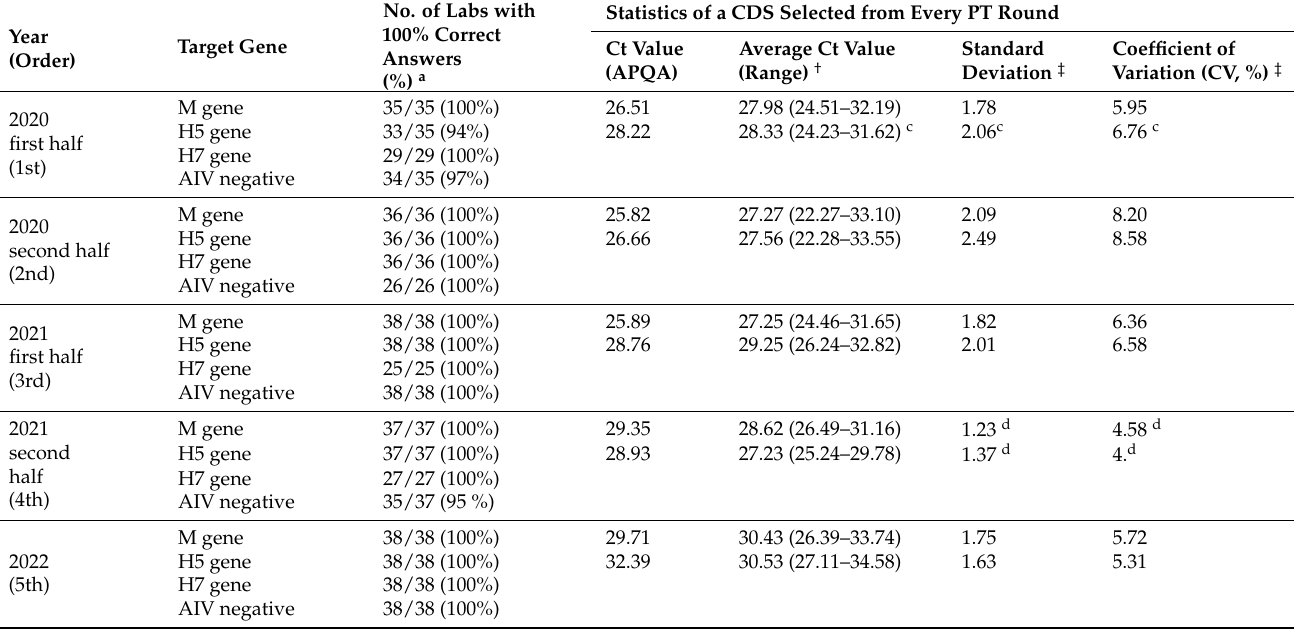
Table 4. Summary of avian influenza virus proficiency test results over 3